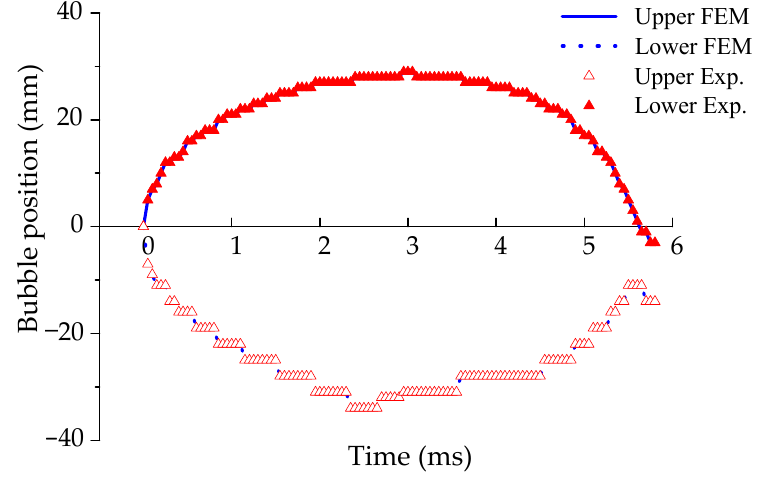
Figure 11. The position of the upper bubble surface and the lower bubble surface. ABAQUS 6.14 can simulate the bubble shape in the collapse stage in detail. During the bubble collapse stage, different parts of the bubble shrink at different rates. This unequal shrinkage speed causes the top surface of the bubble to deform and produce a downward jet. Due to the pressure, the water at the top of the bubble rushes into the jet that is being formed, having an impact on the bottom bubble wall. When the bubble begins to shrink and until the jet breaks through the bottom bubble wall, the bubble gradually changes from a spherical shape to a ring shape. Figure 12 shows the image formed by the jet during the bubble collapse stage. At this stage, the bubble area undergoes drastic flow changes. Figure 13 shows the velocity field formed by the jet during the bubble collapse stage. The velocity field shows the size and direction of the jet. Here, we call the bubble form a jet, but the jet does not break through the bottom bubble as a single connected bubble. We call the annular bubble a double connected bubble. At t = 6.1 ms, the single connected bubble became a double connected bubble.